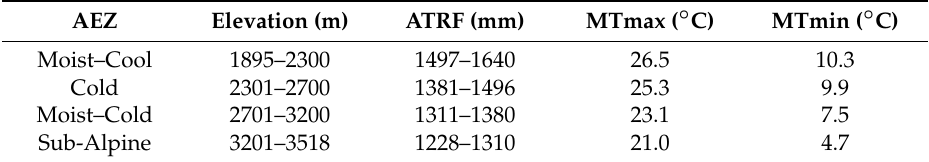
Figure 3. Kriged value of the average annual total rainfall (ATRF) by ordinary cokriging (OCK) for the entire interpolated surface. Table 3. The kriged average values of the average annual total rainfall (ATRF) and temperature in the agroclimatic zones (ACZs) of the Jema